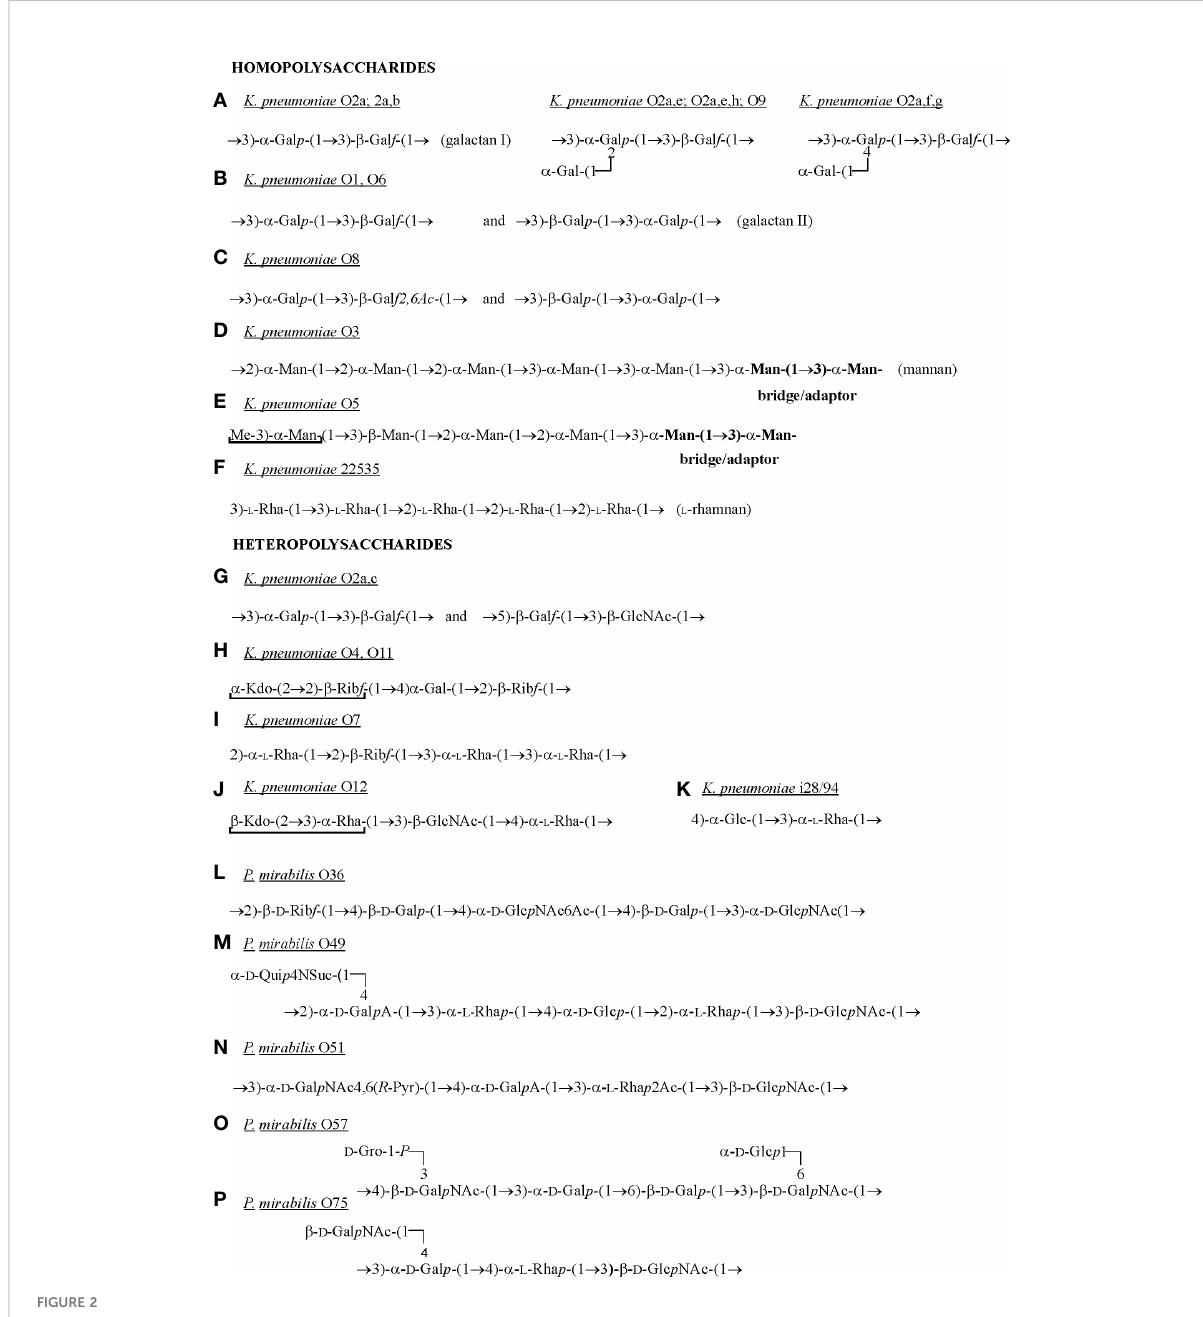
which does not occur in the case of K. pneumonia (Holst, 2007).